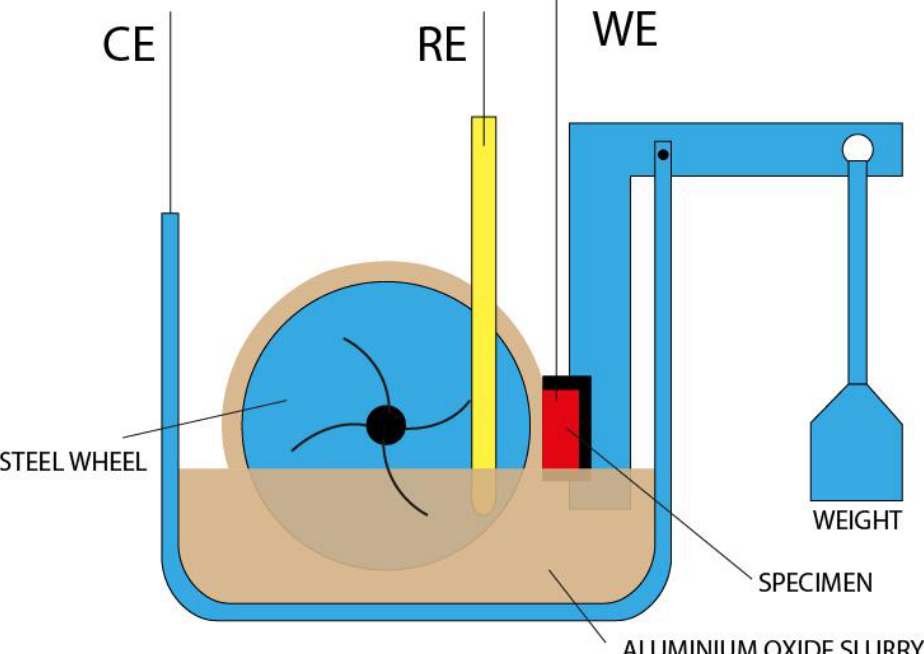
Figure 2. The modified ASTM B611 apparatus. The specimen is the working electrode (WE) and faces the steel wheel that acts as the counter electrode (CE); the slurry interposes between the sample and wheel, establishing the electrochemical cell. The dynamic layer of Al 2 O 3 grains, geometrically separating the WE and the CE, ensure electronic insulation, acting as a separator. The quasi-reference electrode (RE) is a corrosion-resistant hard metal rod.